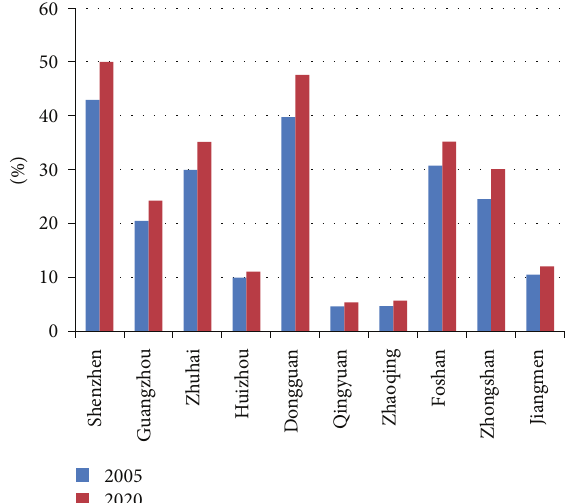
Figure 4: Proportion of built-up land in the total land area in major cities.